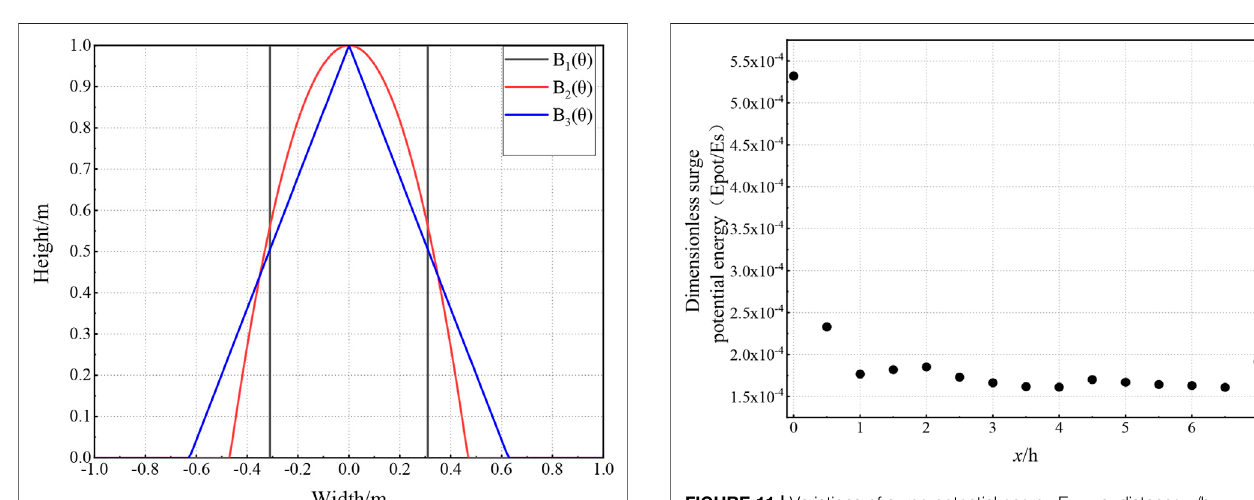
FIGURE 11 | Variations of surge potential energy E pot vs. distance x/h for B 3 ( θ ).